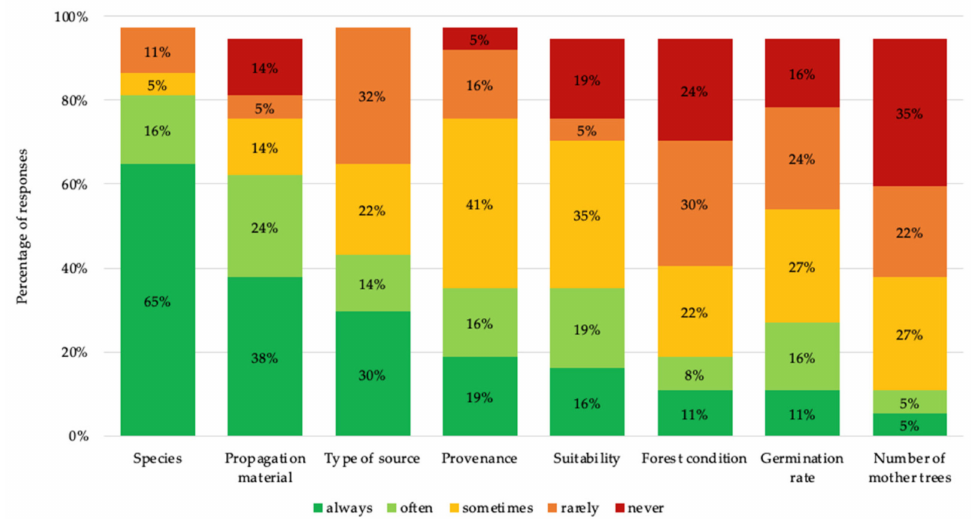
Figure 3. Information about seed that FLR practitioners receive from their seed suppliers (in % of projects per country, total of 37 responses).